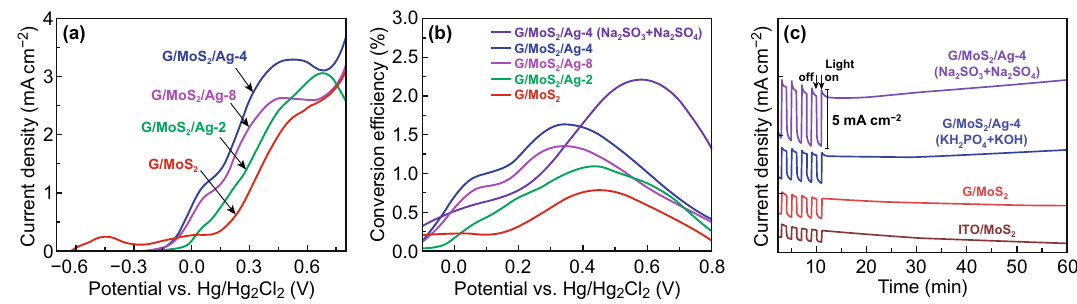
Fig. 8 a Photocurrent density–potential curves of PEC cells with various working electrodes (G/MoS 2 , G/MoS 2 /Ag‑2, G/MoS 2 /Ag‑4, and G/ MoS 2 /Ag‑8) in 0.3 M KH 2 PO 4 + 0.3 M KOH solution. b Photoconversion efficiencies and c photocurrent–time plots for G/MoS 2 , G/MoS 2 /Ag‑2, G/MoS 2 /Ag‑4, and G/MoS 2 /Ag‑8 in 0.3 M KH 2 PO 4 + 0.3 M KOH solution and G/MoS 2 /Ag‑4 in 0.5 M Na 2 SO 3 + 0.5 M Na 2 SO 4